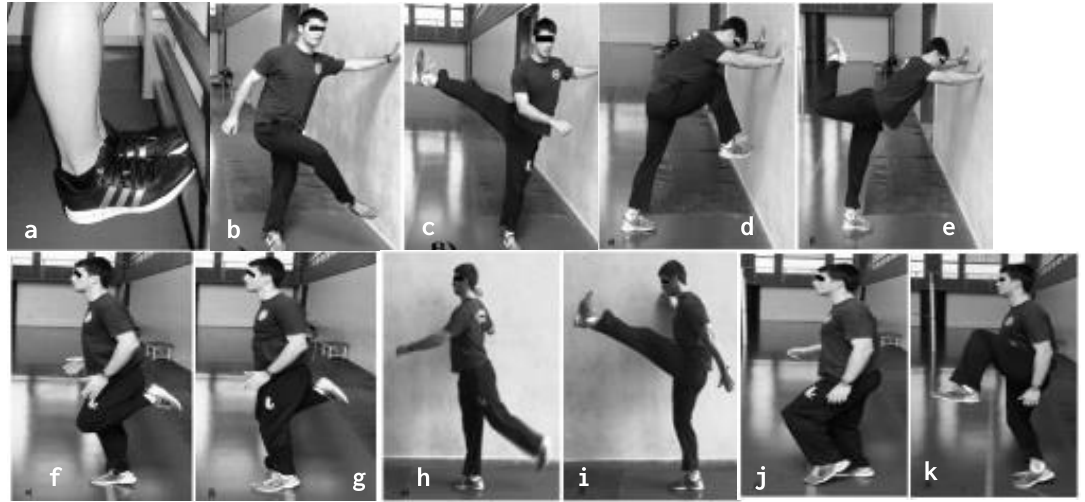
Figure 2. Dynamic stretching protocol exercises of the ( a ) posterior tibial, ( b , c ) topside, ( d , e ) iliopsoas, ( f , g ) front and ( h , i ) posterior crural, and ( j , k ) gluteal muscles.